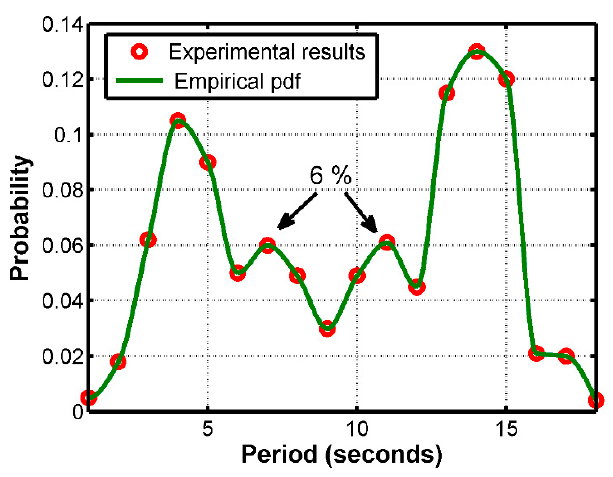
Figure 4. Irregular period waves interactions at the front wall of the